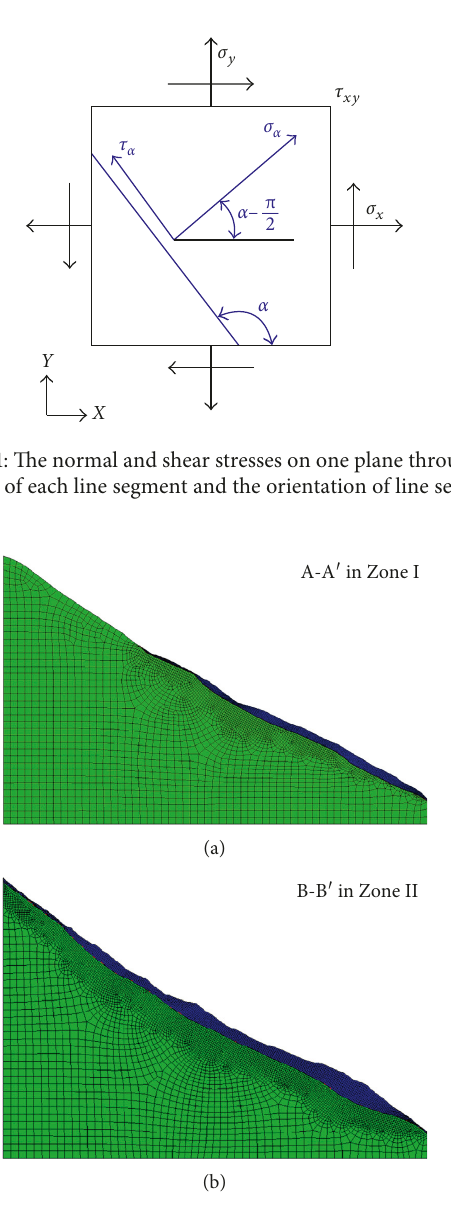
Figure 12: Finite element models of two typical cross sections.